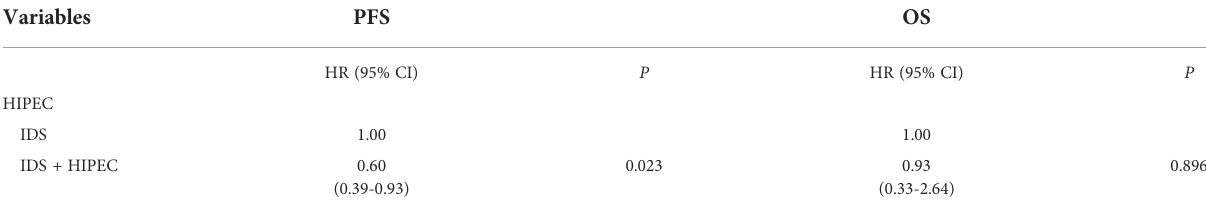
ASA, American Society ofAnesthesiologists; CI, con fi dence interval; FIGO,International Federation ofGynecology and Obstetrics;IDS, interval debulking surgery; HR, hazard ratio; PFS, progression-free survival; OS, overall survival. Models were adjusted by age, ASA score, CA-125 level, FIGO stage, histology, residual disease after IDS, estimated blood loss, operative time, time interval between surgery and the start of adjuvant chemotherapy, chemotherapy regimen, surgical complexity score, BRCA mutation, and cycles of total chemotherapy.